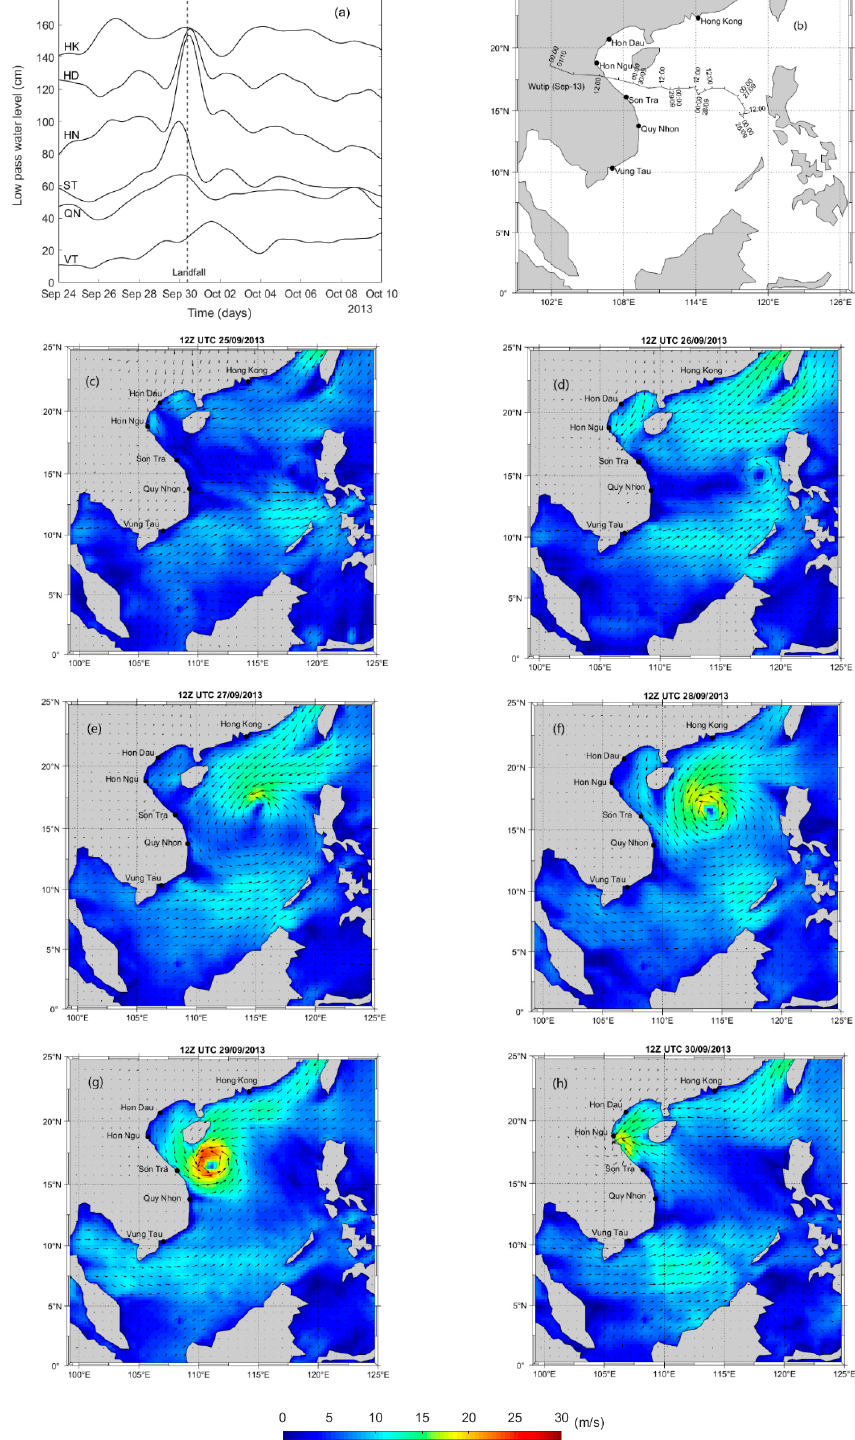
Figure 9. ( a ) Time series of low-pass filtered water levels during Typhoon Wutip (24 September to 9 October 2013) at all stations; ( b ) the track of Typhoon Wutip; and ( c – h )—wind fields at 12Z UTC from 25 September to 30 September 2013. Key: HK: Hong Kong; HD: Hon Dau; HN: Hon Ngu; ST: Son Tra, QN: Quy Nhon; VT: Vung Tau.